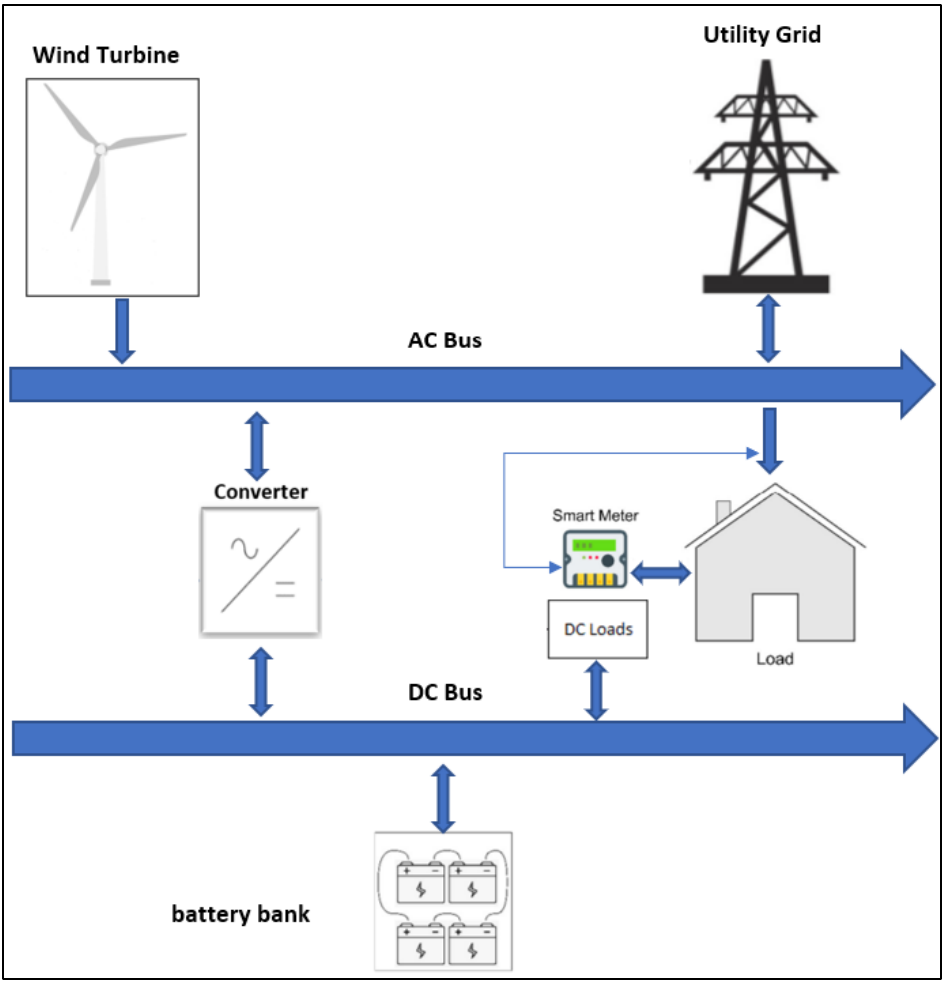
Figure 6. System Block Diagram. Table 1. Details of Wind Turbines.